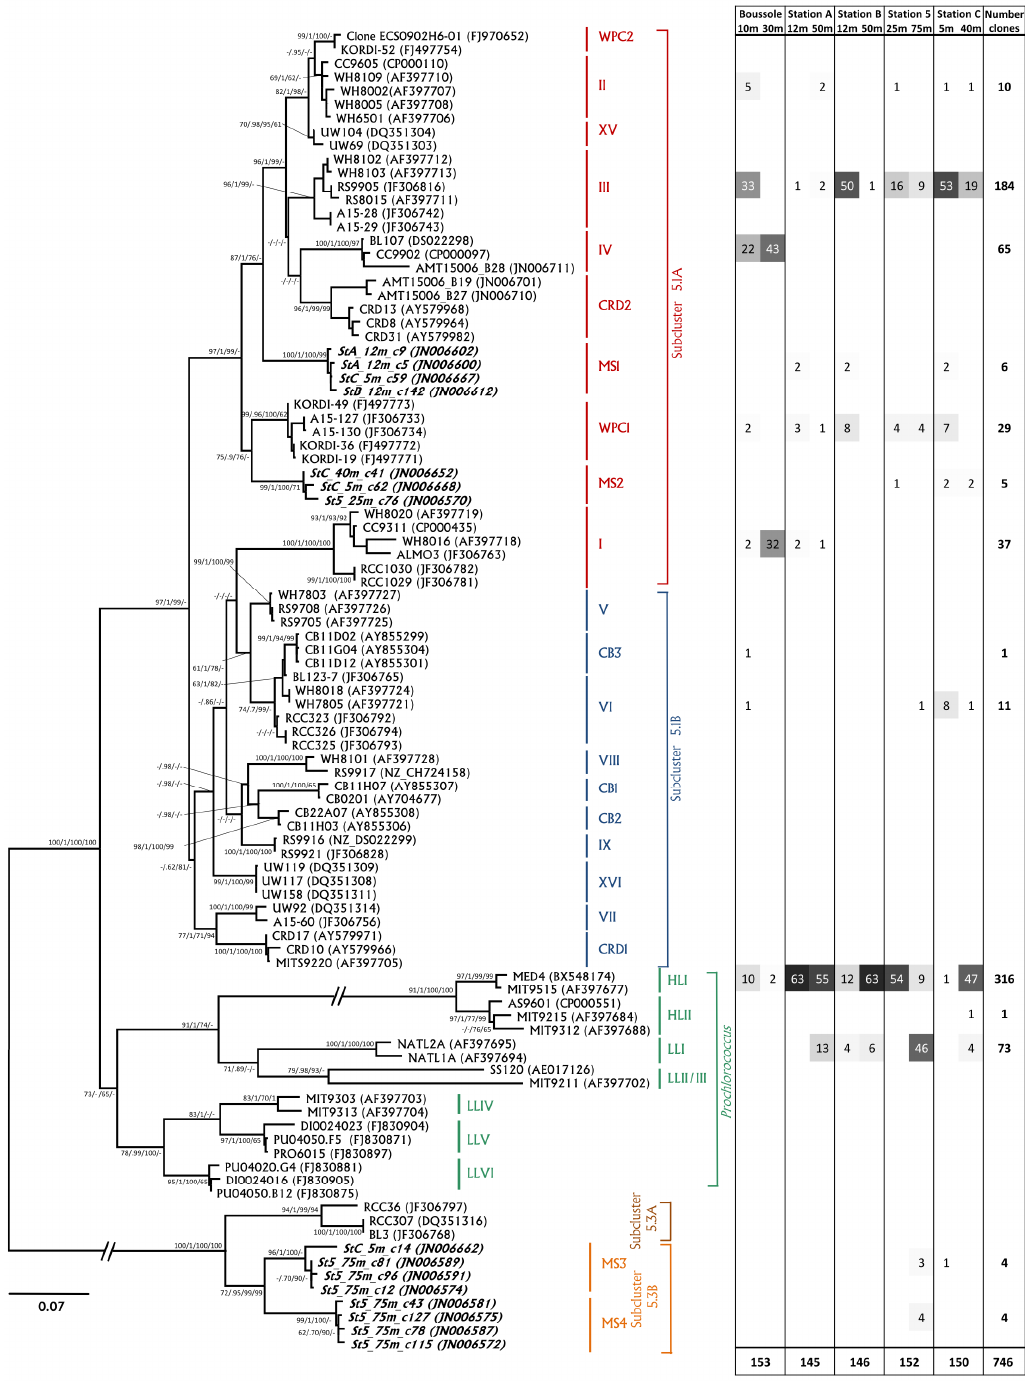
Mella-Flores et al., Fig. 7 Fig. 7. Reference Maximum Likelihood (ML) tree of ITS sequences (based on a sequence alignment of 1135 positions, including tRNA) and table summarizing the number of clones of the different Synechococcus and Prochlorococcus clades/ecotypes for each clone library obtained from samples collected during the BOUM cruise. Novel environmental groups discovered during BOUM (MS1-4) were included in the reference tree and are shown in bold italics letters. The nomenclature used to name the BOUM samples is as follows: stX Ym cZ where × indicates the station number, Y, the sampling depth in meters and Z, the clone number. For sequence submission, the prefix “BOUM ” has been added in front ofthesequencename. Theclade/ecotypenumberornameasreportedintheliterature(AhlgrenandRocap, 2006; Chenetal., 2006; ChoiandNoh, 2009; Fulleretal., 2003; Dufresne et al., 2008) are indicated in colored letters for each group. Sequences belonging to the Synechococcus marine sub-cluster 5.3 were used as an outgroup. Numbers at nodes of the phylogenetic tree correspond to bootstrap values for ML analyses, posterior probability of Bayesian method (ranging between 0 and 1), and bootstrap values for Neighbor-Joining and Parsimony methods, respectively. Bootstraps, represented as a percentage, were obtained through 1,000 repetitions and only values higher than 60% are shown. The scale represents 0.07 substitutions per nucleotide. Branches corresponding to the Prochlororoccus HL ecotypes and Synechococcus marine sub-cluster 5.3 have been cut for readability (their full length is 0.36 and 0.5 substitutions per nucleotide, respectively). The table on the right indicates the number of sequences in clone libraries constructed for each station and depths; their vertical position in the table corresponds to their clade affiliation in the tree, as determined by Pplacer (see text). Numbers in the table are highlighted with increasing degree of